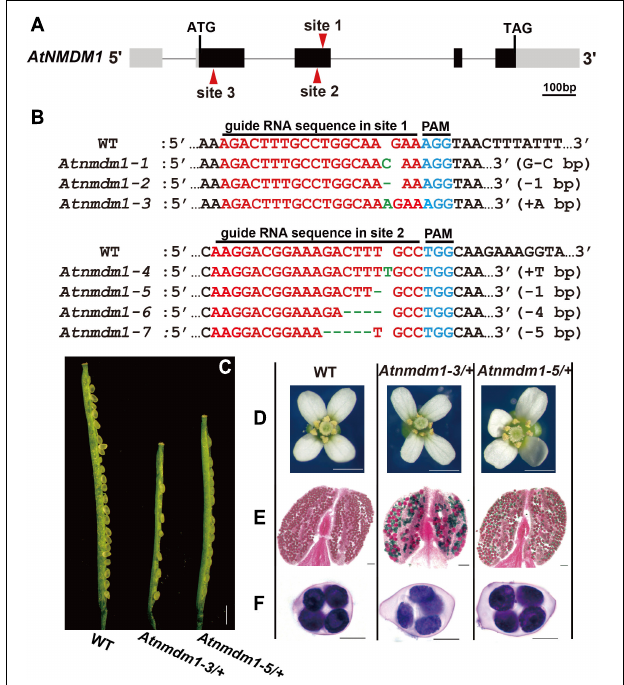
FIGURE 1 | Genotype and phenotype analysis of AtNMDM1 + / − mutants. (A) The genomic structure of the AtNMDM1 from Arabidopsis. Exons are represented by black boxes. Introns are shown by a dashed line. The three target sites (site 1, site 2, and site 3) are indicated by red arrows. The length of AtNMDM1 is 1344 bp. (B) The various mutations of the AtNMDM1 allele were generated by the CRISPR/Cas9 genome-editing system in T1 plants. The wild-type sequence is shown at the top with the PAM sequence highlighted in blue and the target sequence in red. Green dashes and letters indicate deleted bases and insertions or changed bases, separately (+, insertion; –, deletion; letter-letter, changed). (C–F) The phenotypes of the AtNMDM1 + / − mutants, Atnmdm1-3/ + and Atnmdm1-5/ + were analyzed. (C) Silique length of Atnmdm1-3/ + and Atnmdm1-5/ + were obviously shorter than in the wild type (WT) and unfertilized ovules were obvious in Atnmdm1-3/ + and Atnmdm1-5/ +. Bar = 1 cm. (D) The number of pollen grains in Atnmdm1-3/ + and Atnmdm1-5/ + were less than in the wild type. Bar = 1 mm. (E) Alexander staining of anthers of wild type and Atnmdm1-3/ + and Atnmdm1-5/ +. Note that normal pollen grains are stained red while dead pollens are stained green. Atnmdm1-3/ + and Atnmdm1-5/ + both displayed around half of their pollen being dead. Bar = 50 µ m. (F) No difference was observed when tetrads were stained with toluidine blue in the wild type and AtNMDM1 + / − mutants: Atnmdm1-3/ + and Atnmdm1-5/ +. Bar = 10 µ